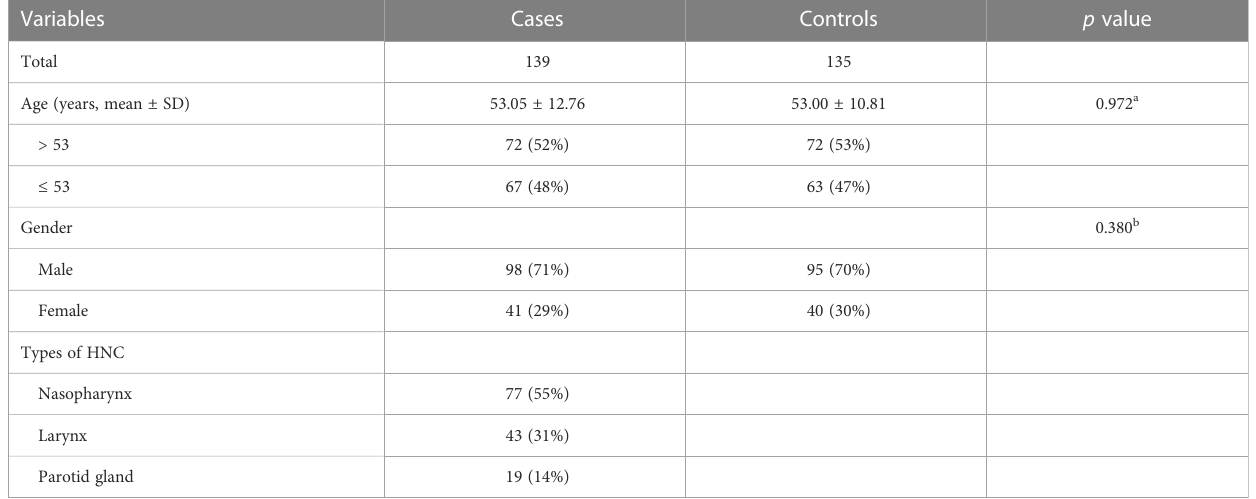
TABLE 1 Demographic characteristics of HNC cases and